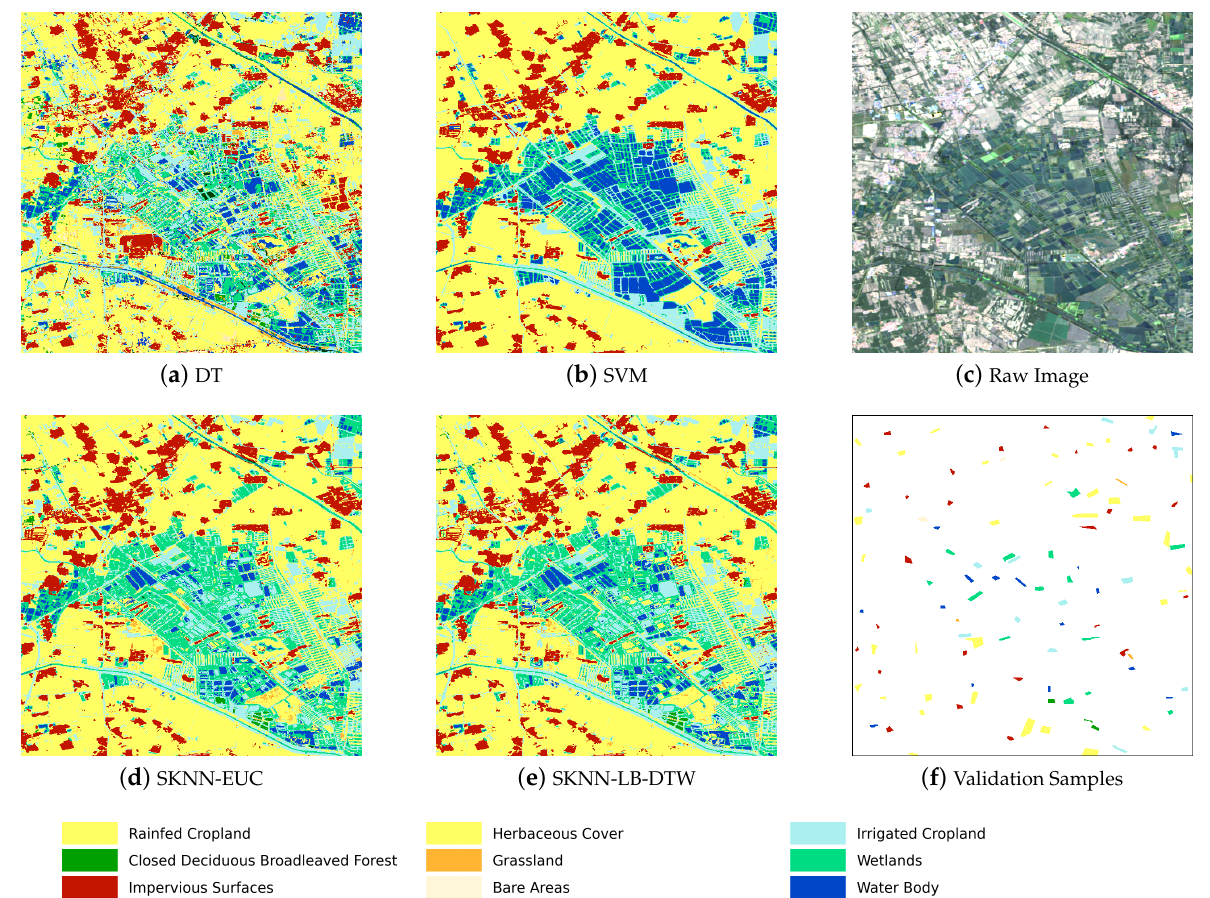
Figure 9. Comparison of classification maps of the first grid with the corresponding validation samples and a reference